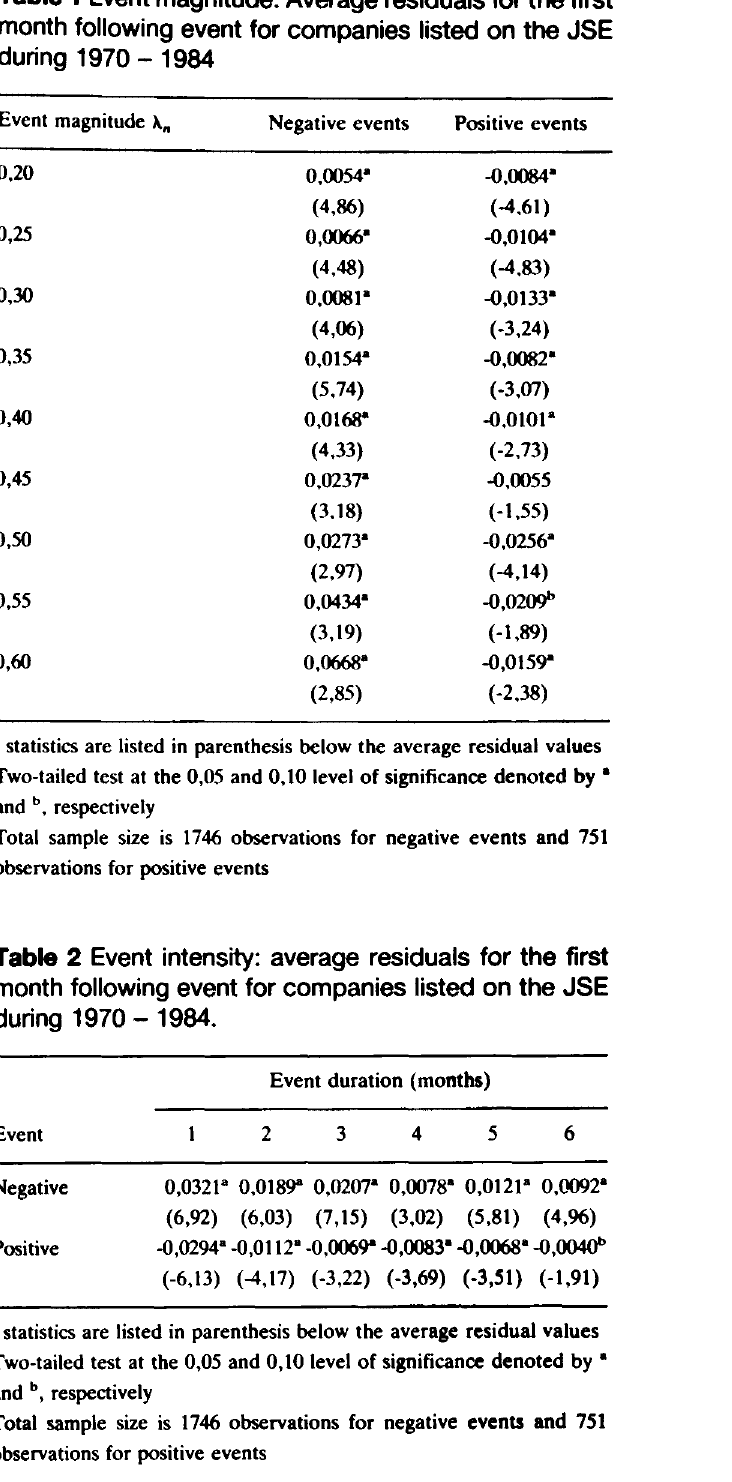
Table 1 Event magnitude: Average residuals for the first month following event for companies listed on the JSE during 1970 - 1984